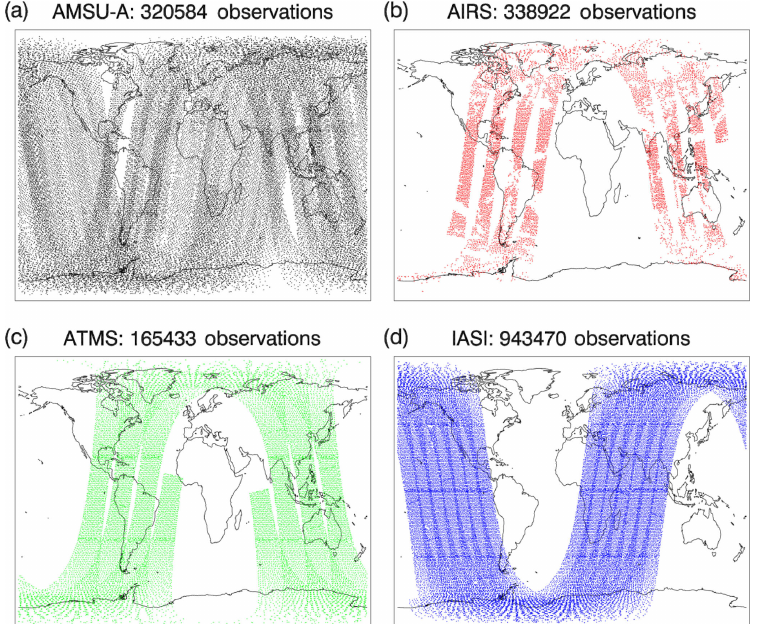
Figure 2. Locations of simulated radiance observations for one 6h update cycle centered on 15 November 2014 (06:00Z). Panels show observation locations for (a) AMSU-A, (b) AIRS, (c) ATMS, and (d) IASI.